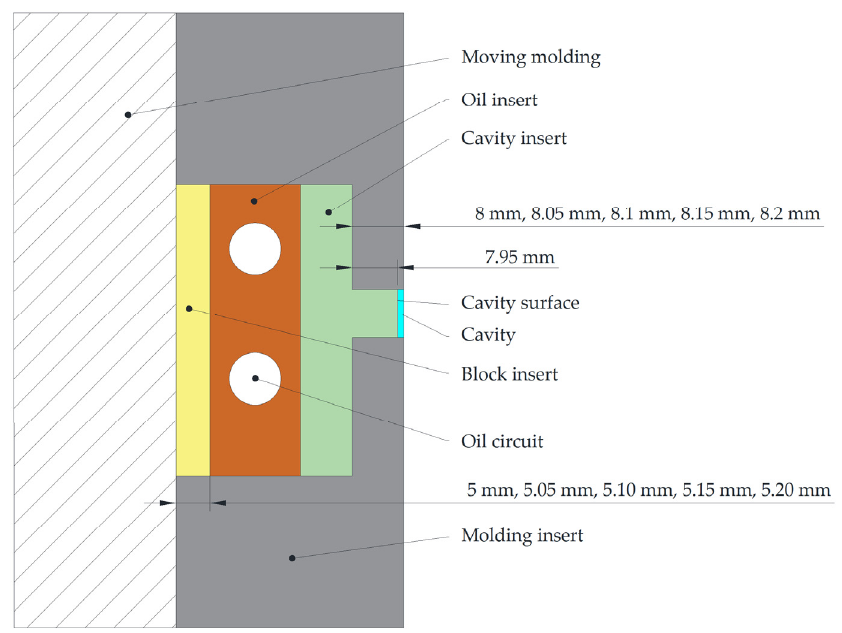
Figure 2. The specific assembly scheme of the die.